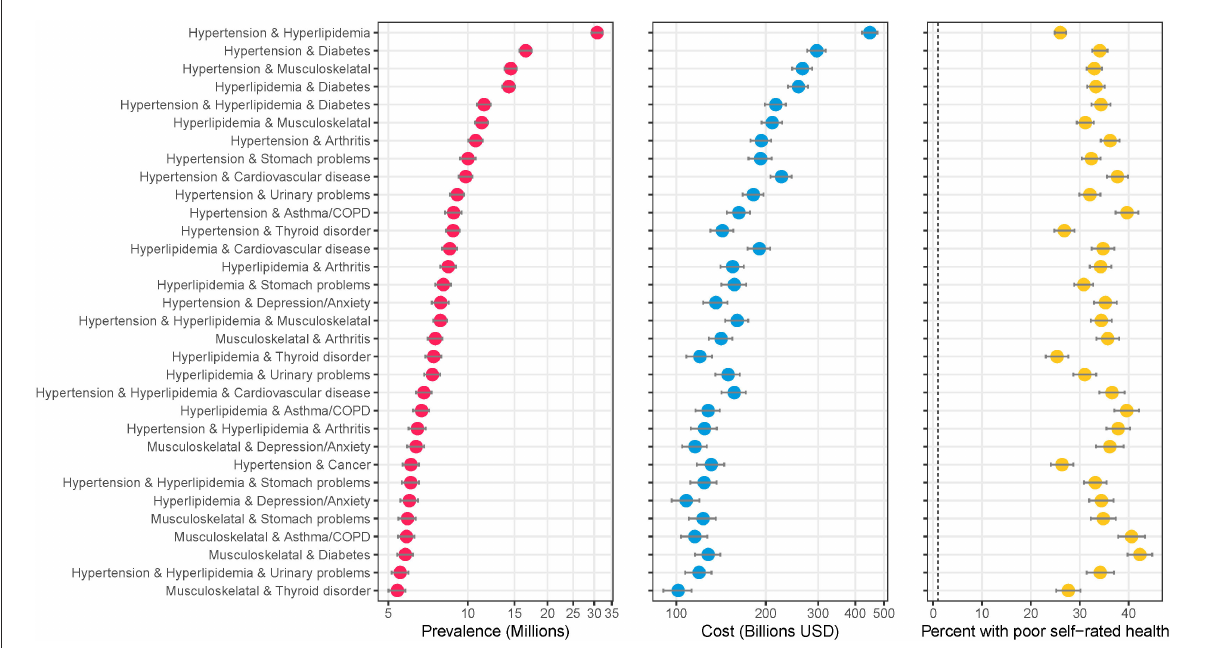
FIGURE1 Highly prevalent specific combinations of multimorbidity and associated cost and perceived poor health. The figure shows combinations of conditions with an estimated prevalence of 5 million or more adults in the United States. Data source: the 2016–2019 Medical Expenditure Panel Survey (MEPS). Weighted estimates and 95% confidence intervals were calculated by applying population weights using Taylor-series methods (i.e., complex survey methods) to account for the complex sampling design of the MEPS. Weighted estimates have been annualized by taking the average over the 4-year study period. X-axes for prevalence and cost are on the logarithmic scale. Results are sorted by prevalence. Cost is measured as total annual medical expenditures in 2019 US Dollars, and perceived health is an answer of “fair” or “poor” on a 5-point question asking respondents to rank their overall